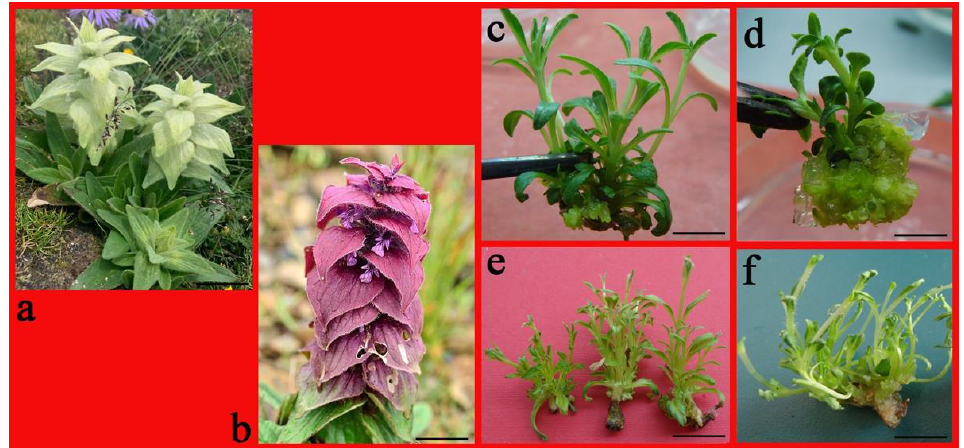
Figure 1. The widely grown Ajuga lupulina plants and its axillary shoot proliferation. ( a ) A. lupulina with yellowish white bracts. ( b ) A. lupulina with purple bracts. ( c ) Axillary shoot proliferation on 2.0-mg L −1 BA-containing culture, demonstrating some callus at the base. ( d ) Axillary shoot germination on 2.0-mg L −1 TDZ-containing culture with evident callus at the base; ( e ) Axillary shoot proliferation on 2.0-mg L −1 ZT-containing culture and. ( f ) 2.0-mg L −1 KT-containing culture with little callus and hyperhydric leaves. Bar = 3 cm ( a , b ), 1 cm ( e , f ), 5 mm ( c , d ).